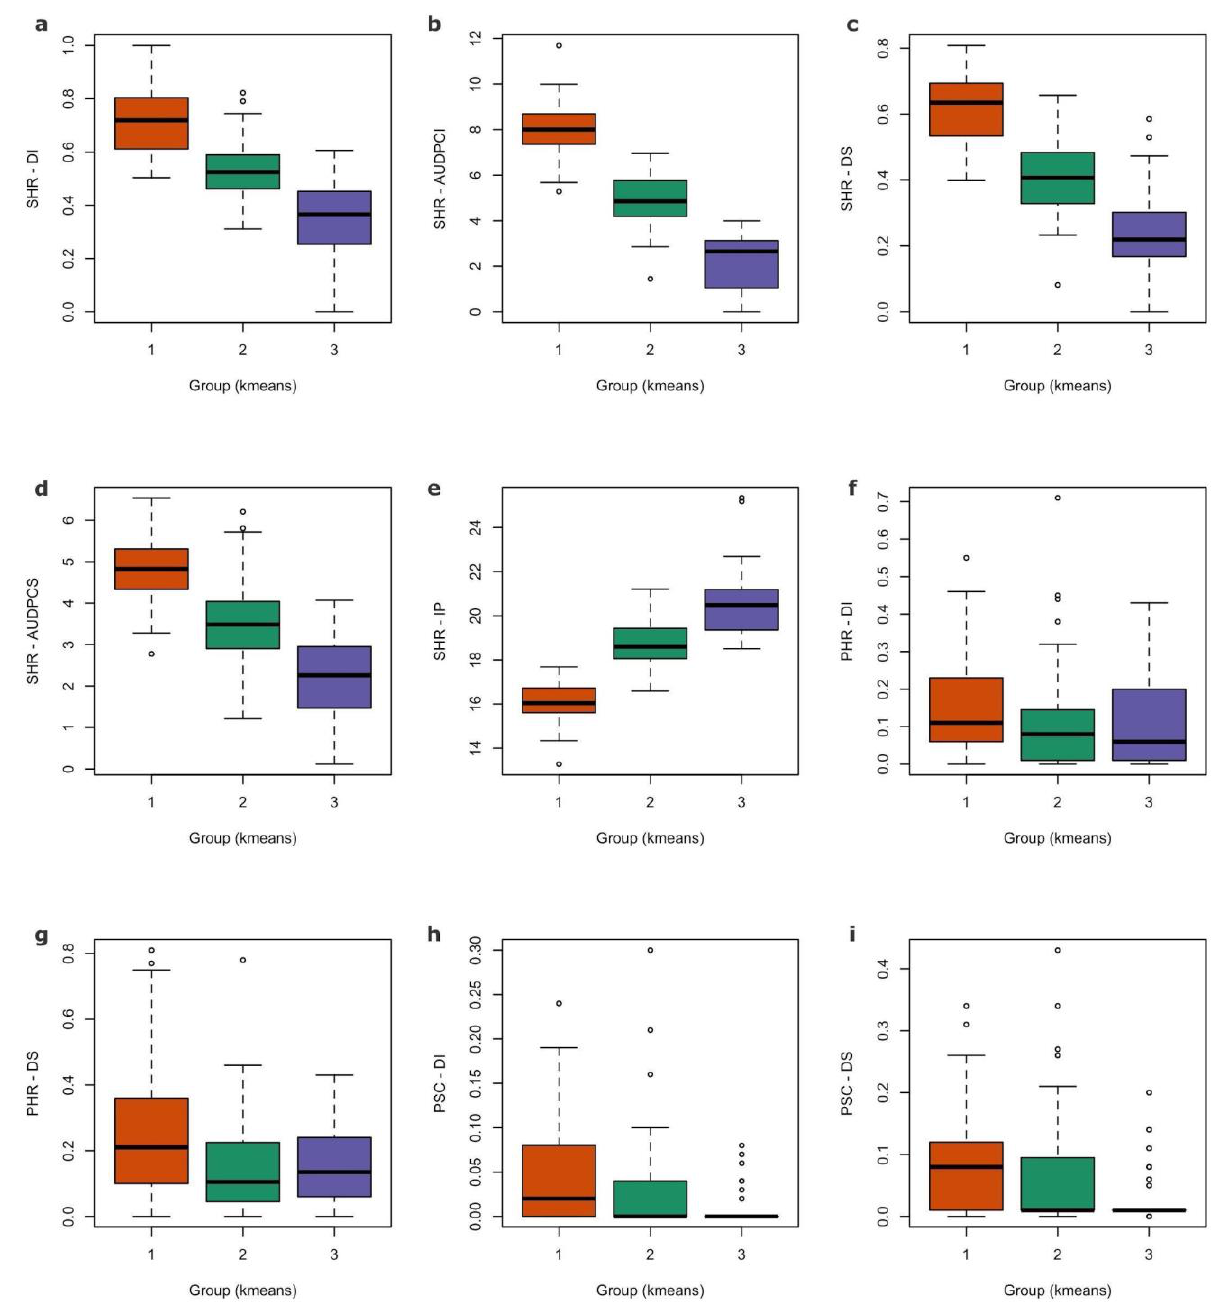
Figure 2. Boxplots of disease response of AMP inbred lines, discriminated by their k-means grouping (three groups): ( a ) Sclerotinia head rot (SHR) disease incidence (DI); ( b ) SHR area under the disease curve for DI (AUDPCI); ( c ) SHR disease severity (DS); ( d ) SHR AUDPC for DS (AUDPCS); ( e ) SHR incubation period (IP); ( f ) Phomopsis head rot (PHR) DI; ( g ) PHR DS; ( h ) Phomopsis stem canker (PSC) DI; ( i ) PSC DS.